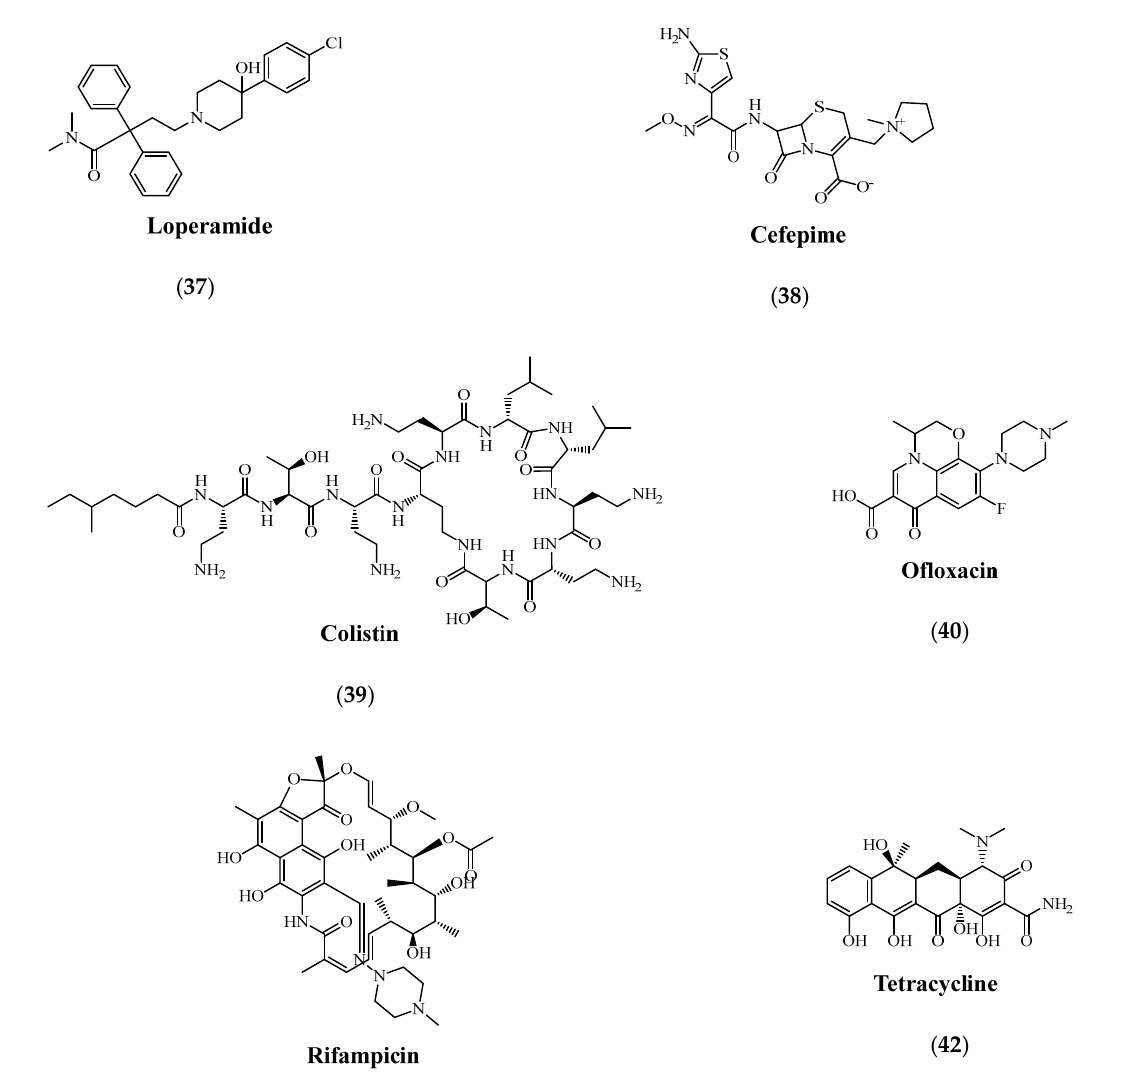
Figure 7. Chemical structures of antimicrobial agents.